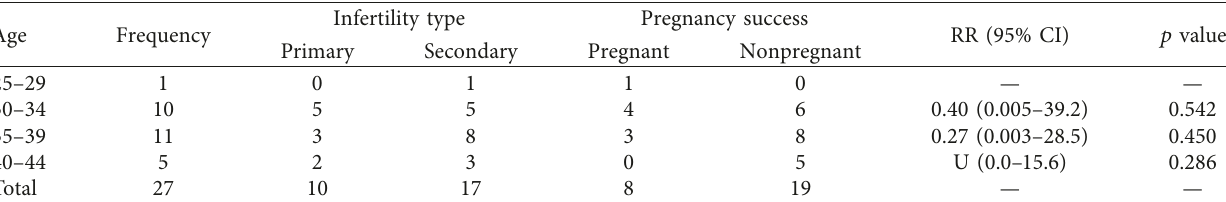
Figure 1: Flow pattern of women that had proximal tubal cannulation. IUI � intrauterine insemination. ∗ Previous unilateral salpingectomy. Table 1: Relationship between age, infertility type, and pregnancy